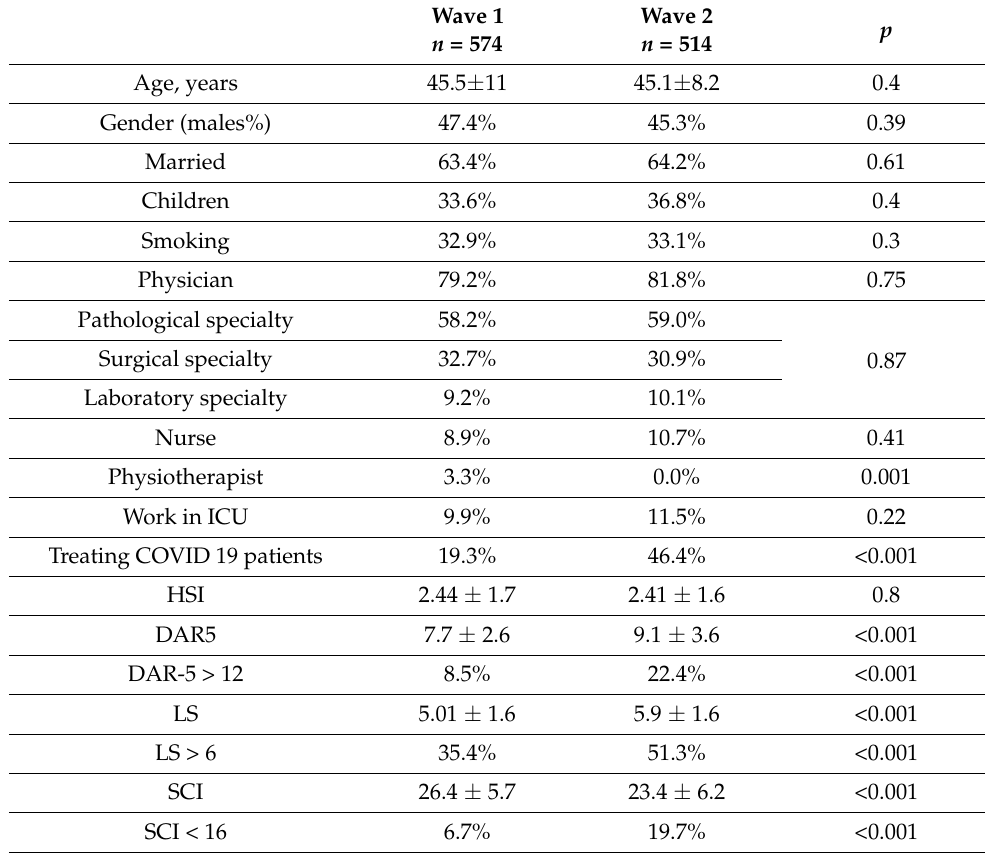
Table 1. Differences between socio-demographic characteristics, mental health indices and sleep quality of al the responders of the 1st and of the 2nd wave. (Mean ±